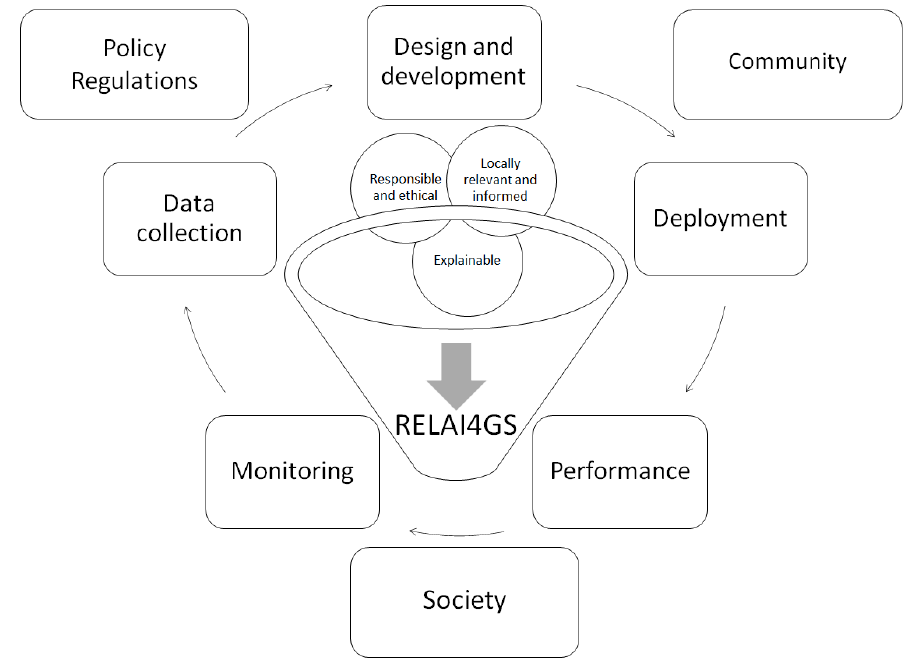
Figure 1. The framework adopted to address clinical public and global health needs in the Global South, leveraging and capitalizing on our experience with the “Africa-Canada Artificial Intelligence and Data Innovation Consortium” (ACADIC) Project in the Global South (“Responsible, Explainable, and Local Artificial Intelligence for Clinical Public and Global Health in the Global South”, REL- AI4GS). The diagram coherently shows the “how”, the “what”, and the “who” of our proposed framework. The inner shell (“how”) contains the set of ethical and legal rules and codes that should be designed in such a way that they are responsible (incorporating policy and regulations), locally relevant for communities, and explainable to society at large. Moreover, they should be applied and embedded all along the processes of AI solutions in the Global South. The medium shell (“what”) describes the processes that should be implemented in an iterative fashion (step 1: data collection, step 2: design and development, step 3: deployment, step 4: performance, and step 5: monitoring). The outer shell (“who”) contains all the relevant stakeholders and actors that should be involved. Table 3. The three components of the “Responsible, Explainable, and Local Artificial Intellige nce for Clinical Public and Global Health in the Global South” (REL -AI4GS) framework. Component Definition Responsible Accountable, auditable, compliant, ethical, respectful, safe, secure Explainable Equitable, fair, impactful, interpretable, meaningful, reliable, reproducible, transpar- ent, trustworthy, unbiased Local